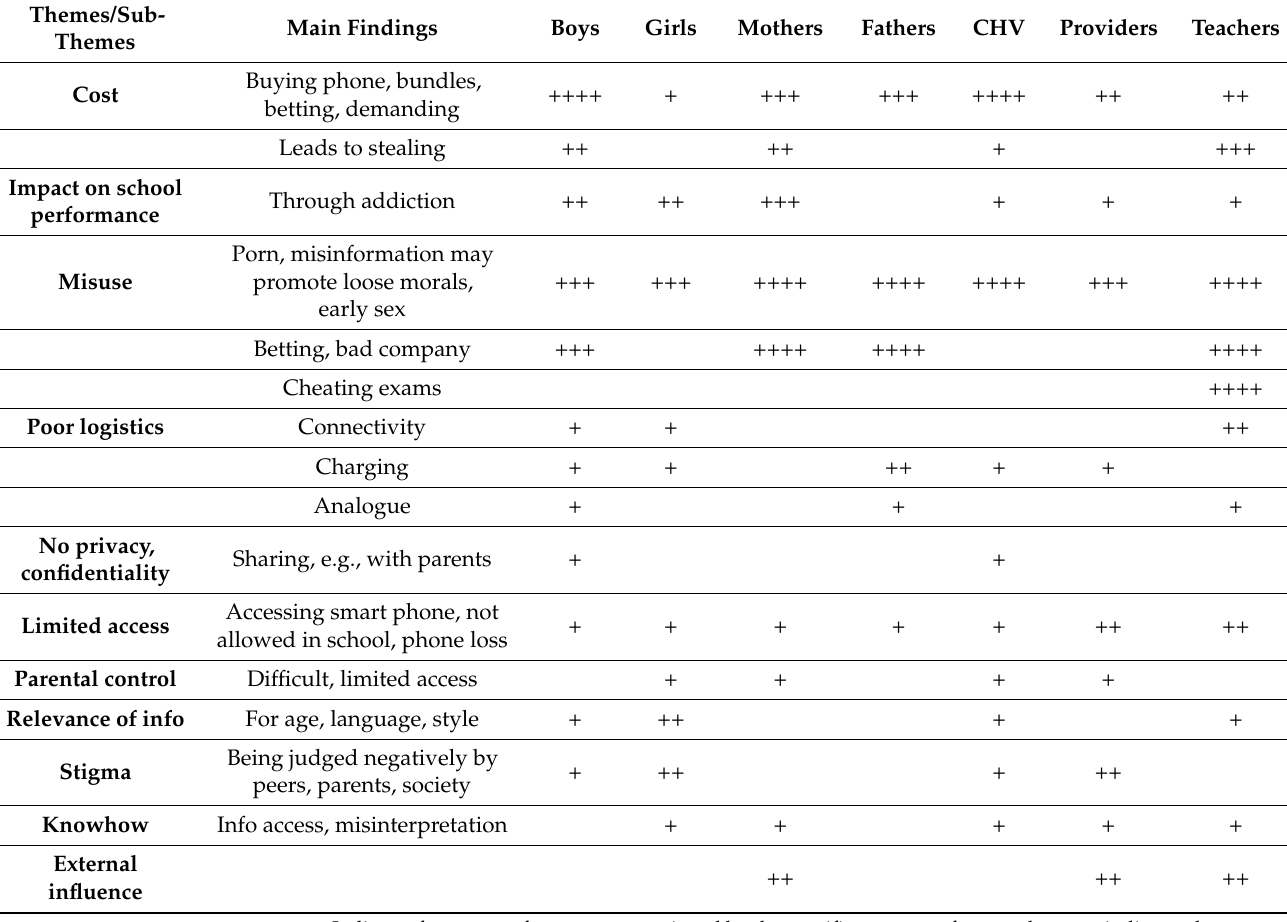
Table 2. Challenges with mobile phones by respondent